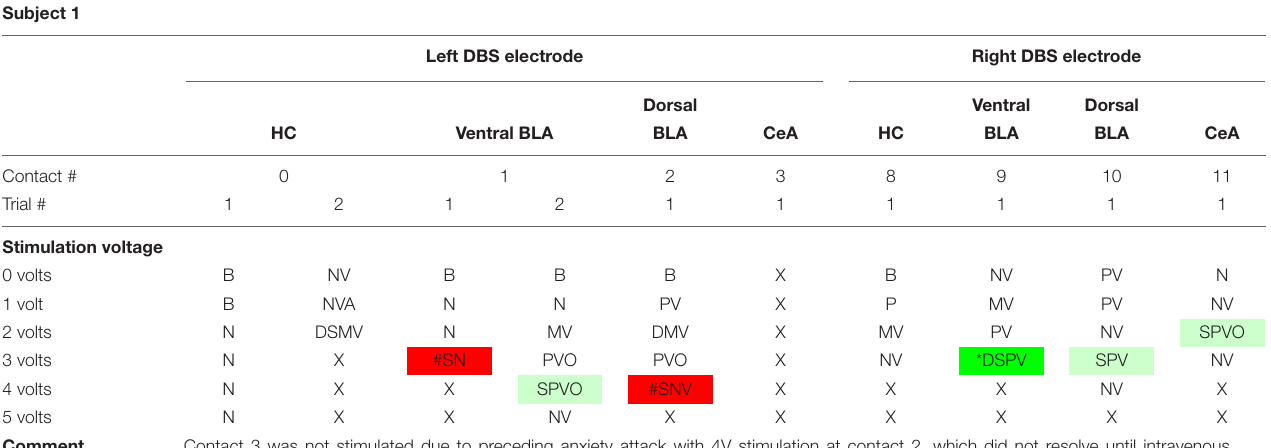
TABLE 1 | Acute stimulation effects of individual DBS electrode contacts in both subjects organized by contact stimulated and stimulation